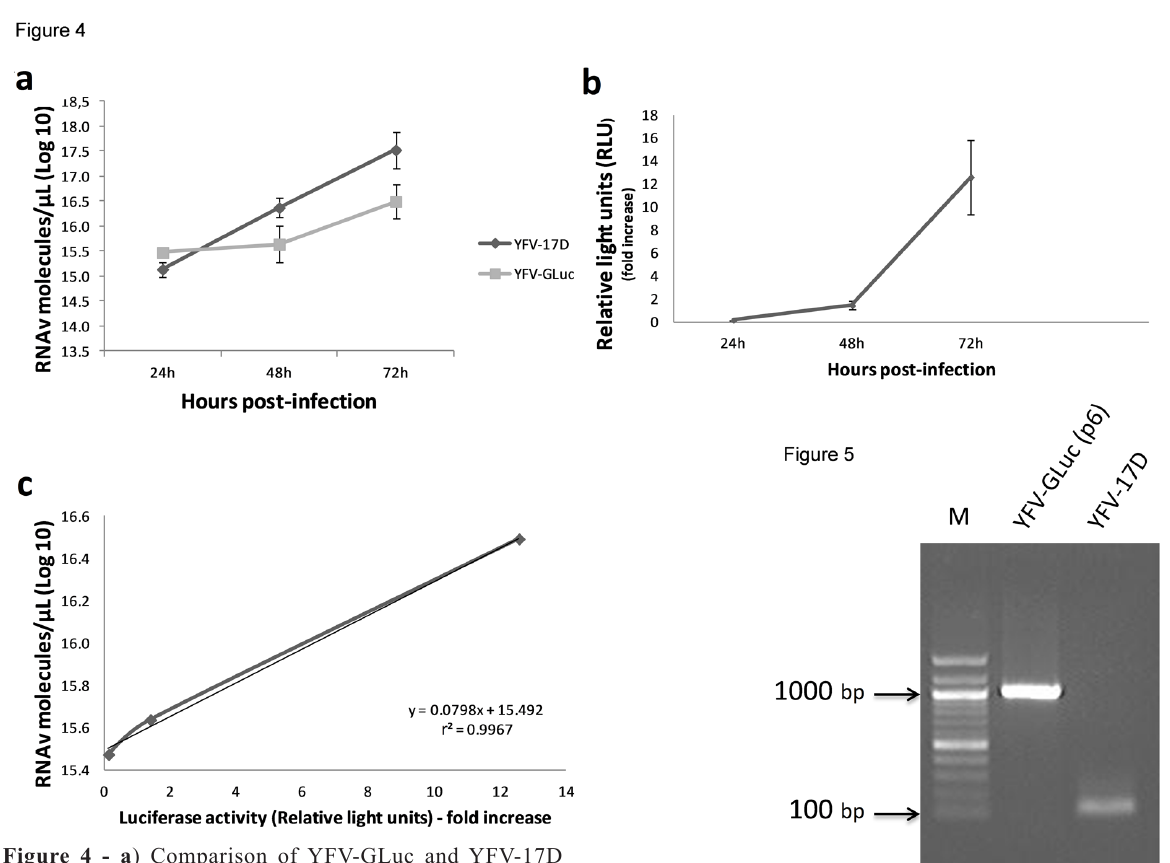
Figure 4 - a ) Comparison of YFV-GLuc and YFV-17D replication kinetics. BHK-21 cells were inoculated with either virus at MOI of 0.1. At indicated times, the supernatant was collected and viral quantitation was assessed through SYBR Green-based quantitative real-time PCR. Each value represents the mean of two independent experiments; b ) Curve of GLuc activity on the supernatant of cells infected with YFV-GLuc (MOI of 0.1). At different time points, the supernatant was collected and GLuc activity was measured and expressed as the fold-increase in relation to time zero using the relative light units. Each value represents the mean of two independent experiments. Each value represents the mean of two independent experiments; c ) Linear correlation between GLuc activity (relative light units) and viral replication (RNAv molecules/µL). The replication kinetics of the YFV-GLuc and curve of Gaussia luciferase expression were overlapping and the direct relationship between them was evaluated by linear regression.